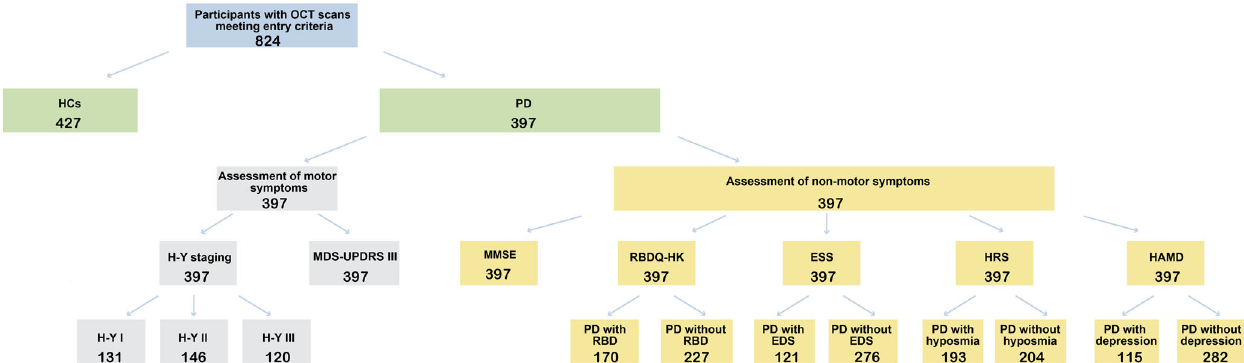
Fig. 1 Flow diagram of participant selection and study design. OCT optical coherence tomography, HCs healthy controls, PD Parkinson ’ s disease, H-Y Hoehn-Yahr, MDS-UPDRS III Movement Disorder Society-Uni fi ed Parkinson ’ s Disease Rating Scale part III, MMSE Mini-Mental State